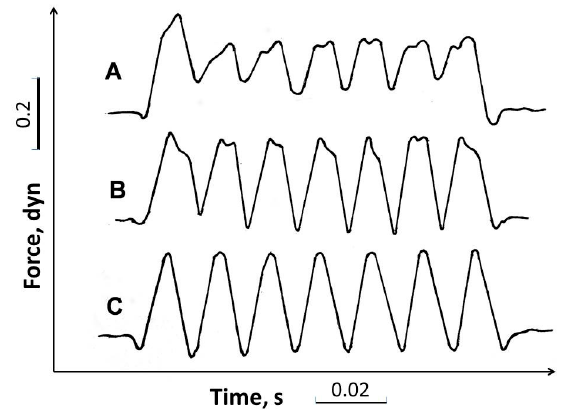
Figure 2. Mechanograms of the resulting propulsive force versus time of the cephalic limbs in Calanus helgolandicus attached to a semiconductor force sensor. ( A ): All cephalic limbs active. ( B ): After the amputation of maxillipeds. ( C ): After the amputation of all mouth appendages, leaving only the second antennas active (from [10]).